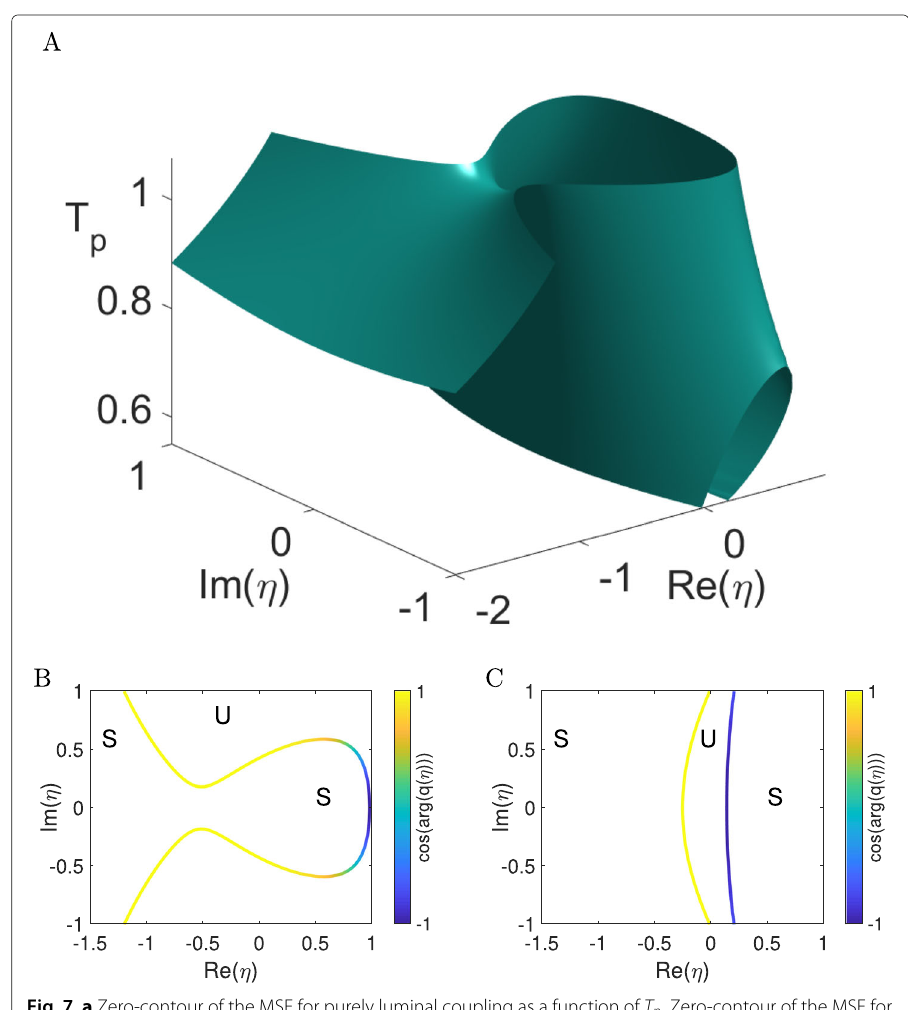
Fig. 7 a Zero-contour of the MSF for purely luminal coupling as a function of T p . Zero-contour of the MSF for T p = 1.075s ( b ) and T p = 0.55s ( c ). The MSF is negative in regions labeled S and positive in regions denoted by U. The colour represents the value of cos ( arg ( q (η)))